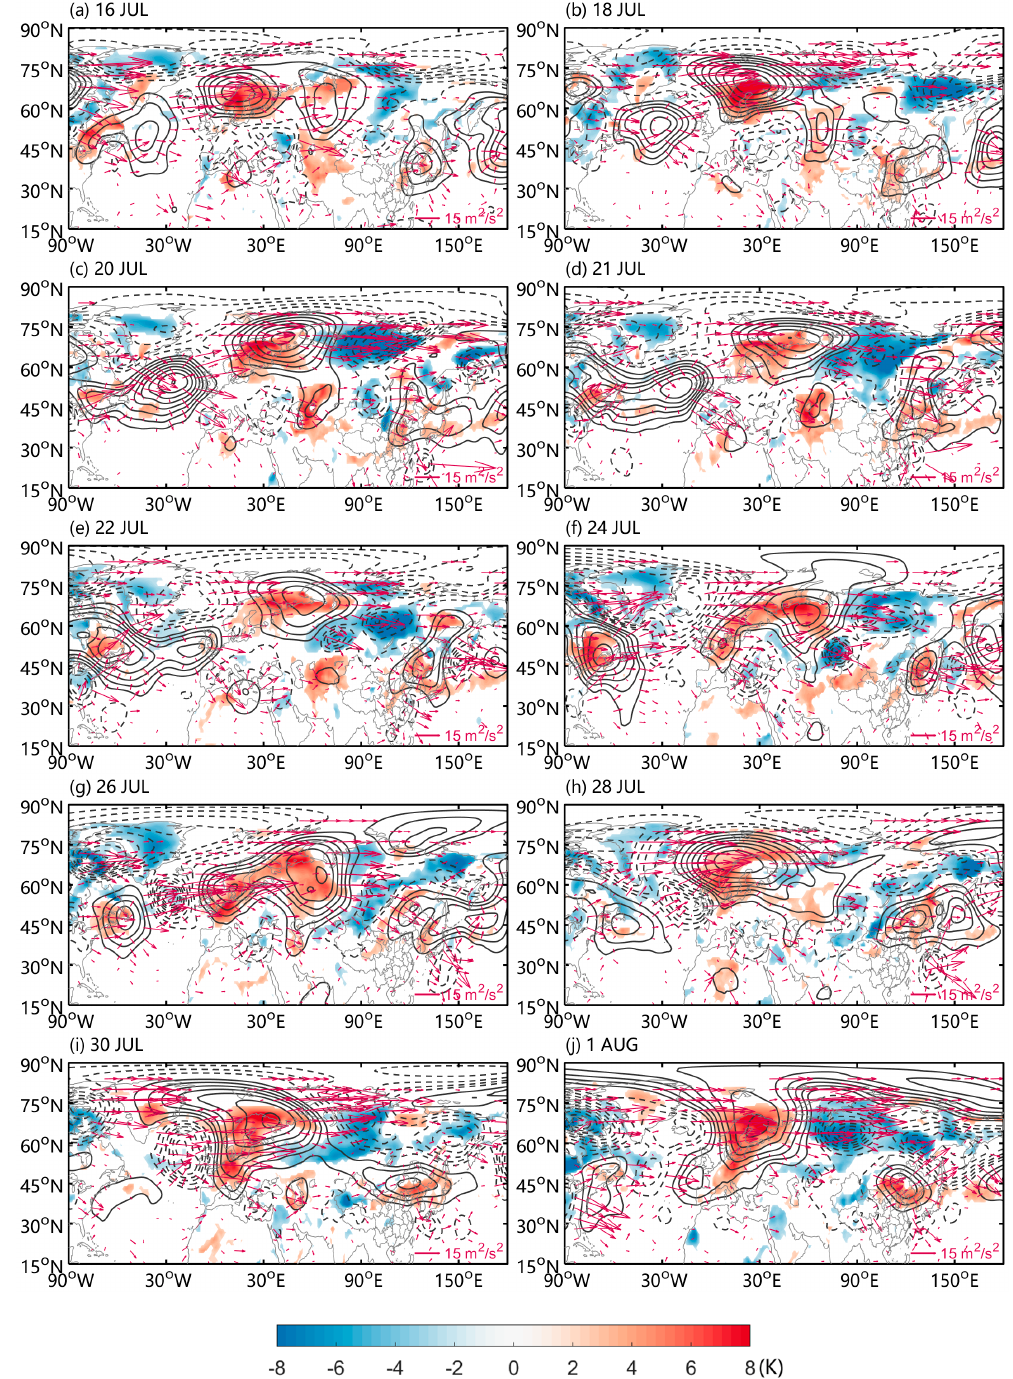
Figure 9. Daily 500 hPa geopotential height anomalies (contours, interval = 30; units: gpm), SAT anomalies (shading; units: K) and horizontal components of the wave fluxes (arrows; units: m 2 /s 2 ) from 16 July to 1 August ( a – j represent the instantaneous daily evolutions). The solid (dashed) contours show positive (negative) 500 hPa geopotential height anomalies.